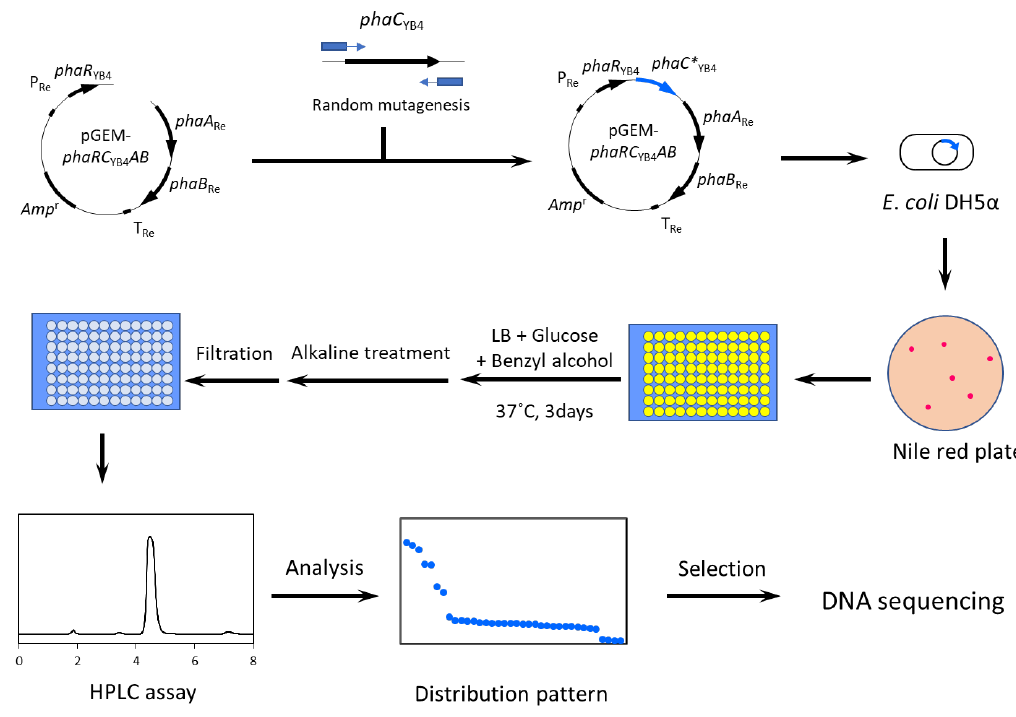
Figure 1. Schematic diagram of the screening method based on the DP of PHA. As a secondary screening, 96-well plate cultivation and HPLC analysis were performed. PHA-accumulating transformants, which exhibit orange fluorescence from captured Nile red under 420–500 nm visible light of a Dark Reader transilluminator (MoBiTec, Göttingen, Germany), were inoculated in 0.6 mL LB medium containing 20 g/L glucose, 1 mL/L benzyl alcohol, and 100 mg/L ampicillin in each well of a 96-deep well plate. After cultivation for 3 days at 37 °C, the cells were collected by centrifugation at 1890× g (3500 rpm) for 5 min and washed twice with pure water. Then, alkaline treatment was performed by adding 200 μL of 1 N sodium hydroxide (NaOH) to the pellet, followed by heating at 100 °C for 3 h in a dry bath with an aluminum block (TAITEC Co., Saitama, Japan). For more details, see Ref. [21]. After cooling, the reactants were neutralized with 200 μL of 1 N hydrochloric acid (HCl) and centrifuged at 1890× g (3500 rpm) for 10 min to precipitate the cell residue. The supernatant was filtered through 96-well filter plates (0.45 µ m pore size hydrophilic polytetrafluoroethylene membrane, Pall Co., Port Washing- ton, NY, USA) by centrifugation. The filtrates were collected into new 96-well assay plates and subjected to HPLC